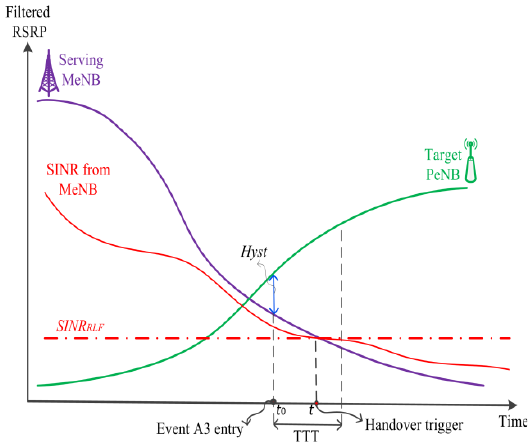
Fig. 5. The handover mechanism for in-pico scenario.